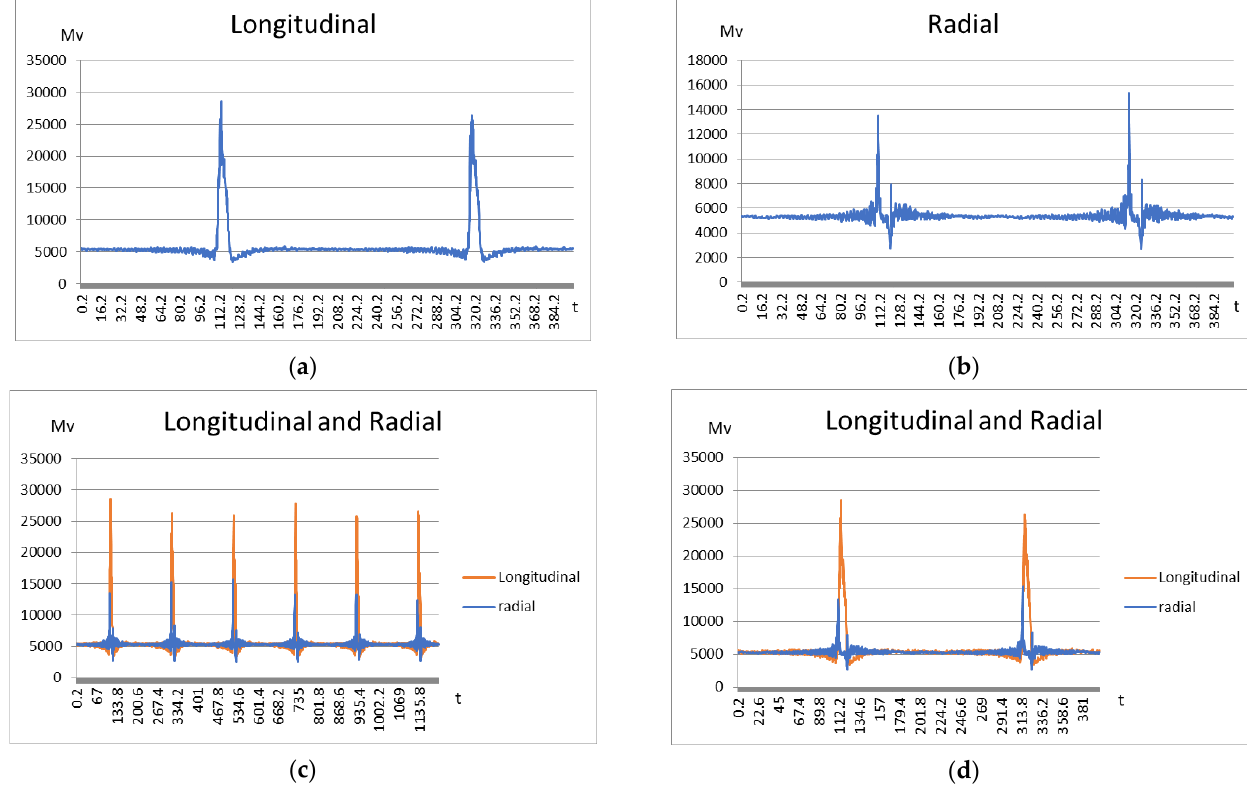
Figure 12. Signal wave: ( a ) longitudinal wave; ( b ) radial wave; ( c ) longitudinal and radial results compared with a 60,000 sample point; ( d ) longitudinal and radial results compared with a 20,000 sample point.